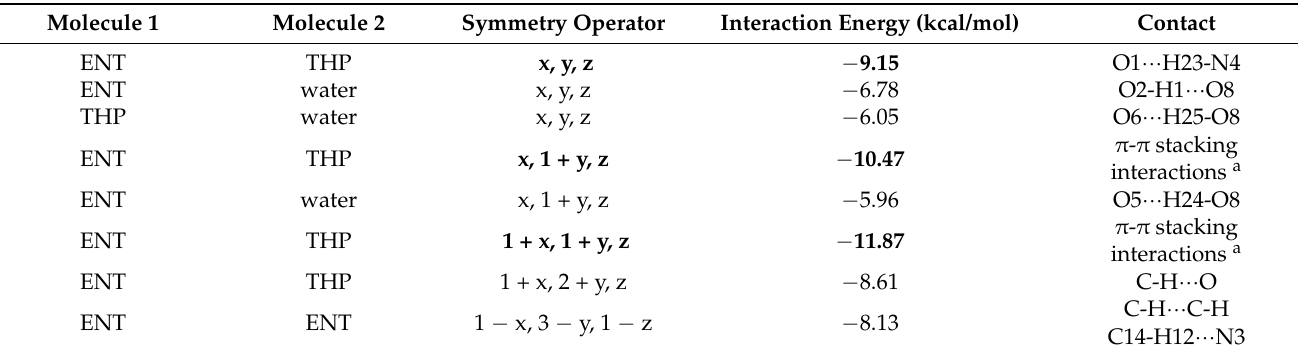
Table 3. Symmetry operators of neighboring molecules (Molecule 2) for basic molecules of cocrystal (Molecule 1) located in the asymmetric unit, interaction energy (kcal/mol), and corresponding contacts of the basic molecules with neighboring molecules of the first coordination sphere (strongest interactions are highlighted in